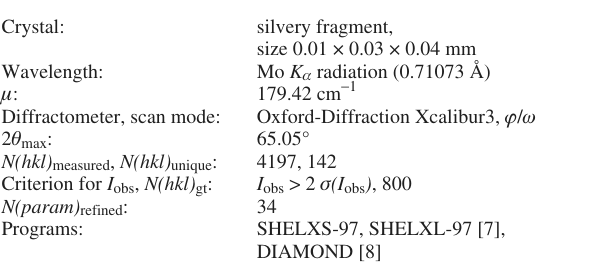
Table 1. Data collection and